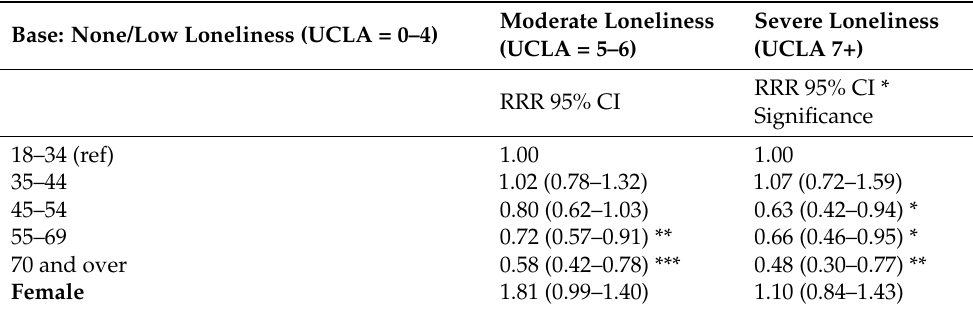
Table 2. Final multinomial logistic regression model for moderate and severe loneliness pre COVID-19